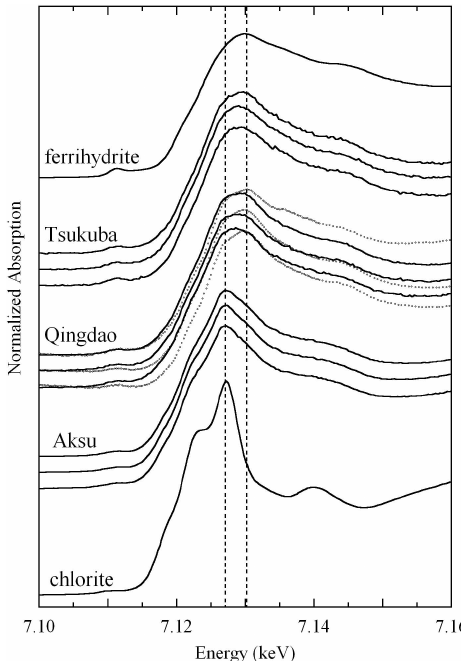
Fig. 7. Normalized Fe K-edge XANES spectra for systematically- collected dust samples. Solid line: FY-XANES; Dotted line: CEY- XANES; Dashed line: main peak position of chlorite and ferrihy- drite. Note the differences in the FY- and CEY-XANES spectra for Qingdao samples and the systematic peak shift among Aksu, Qing- dao, and Tsukuba, suggesting the increase of Fe(III) ratio to total Fe during the atmospheric transport from the Taklimakan Desert to